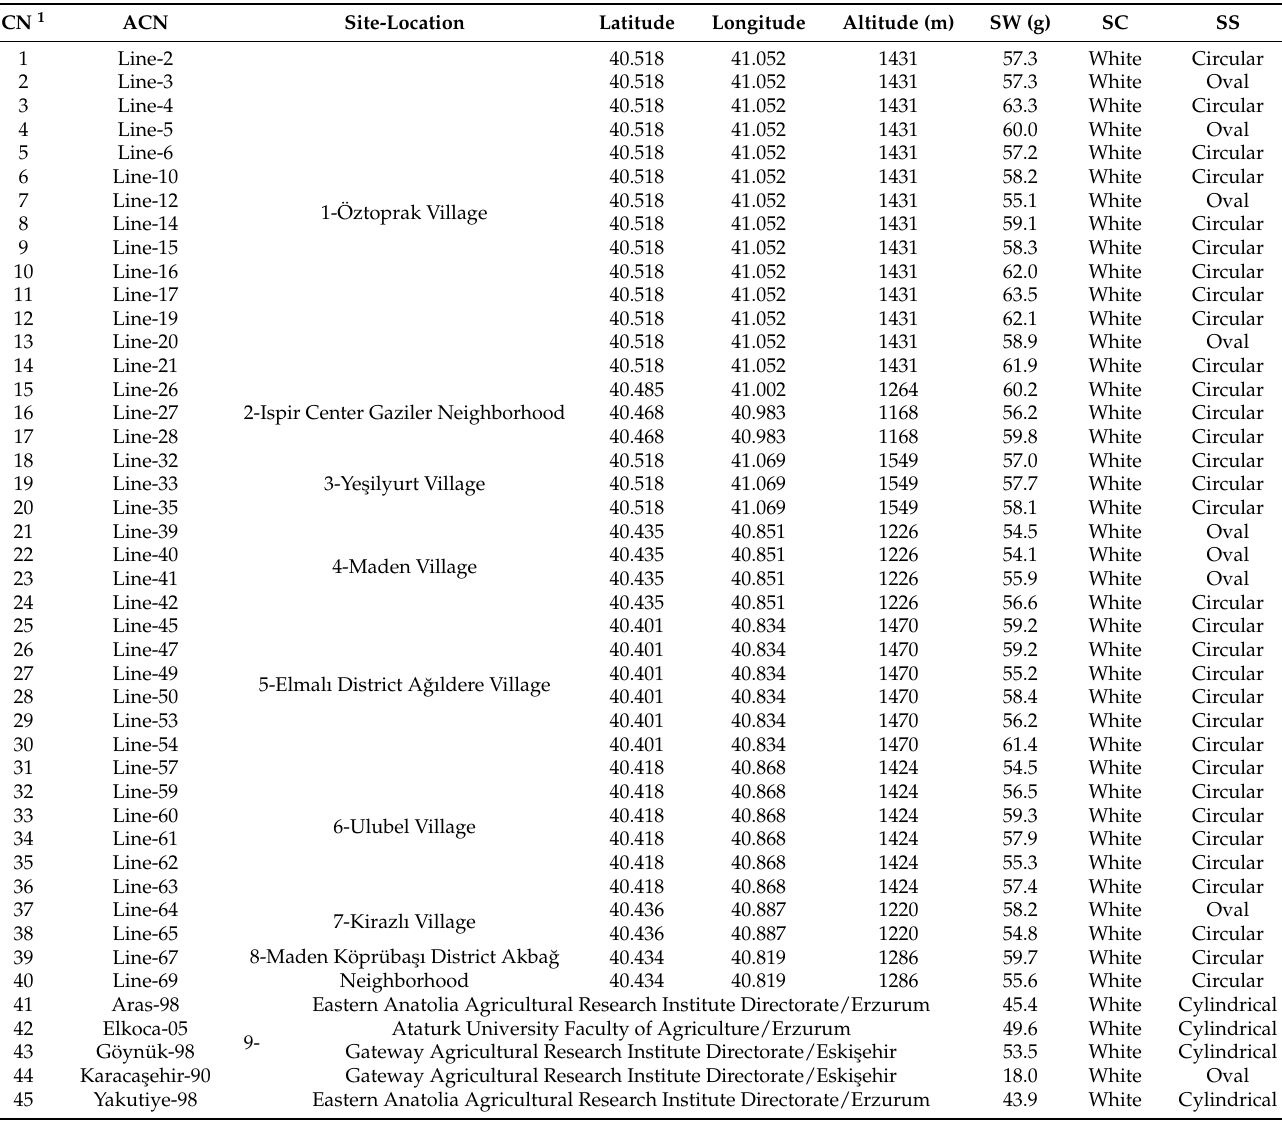
Table 1. List of bean accession by information, coordinates, and some seed characteristics of the gathering place (Figure